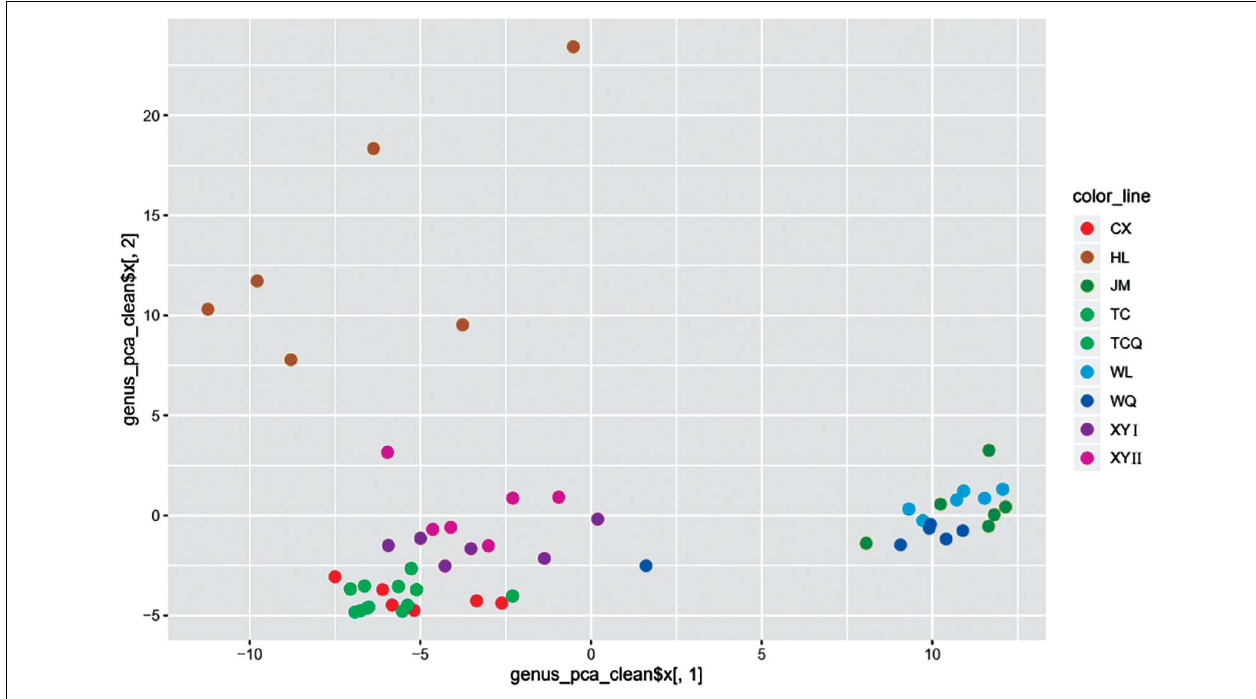
FIGURE 5 | PCA of the bacterial community of CPB collected from nine areas.